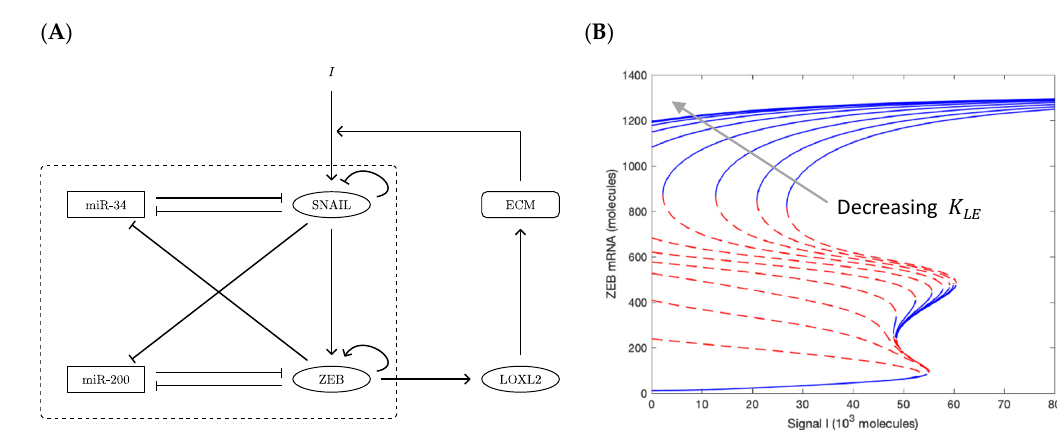
Figure 4. ( A ) Biochemical reaction network of core EMT circuit (within dashed box) plus the LOXL2- and ECM-mediated feedback loop including LOXL2. ( B ) Bifurcation diagrams of EMT core circuit coupled to the LOXL2 feedback loop. Different curves following the arrow correspond to different thresholds K LE .